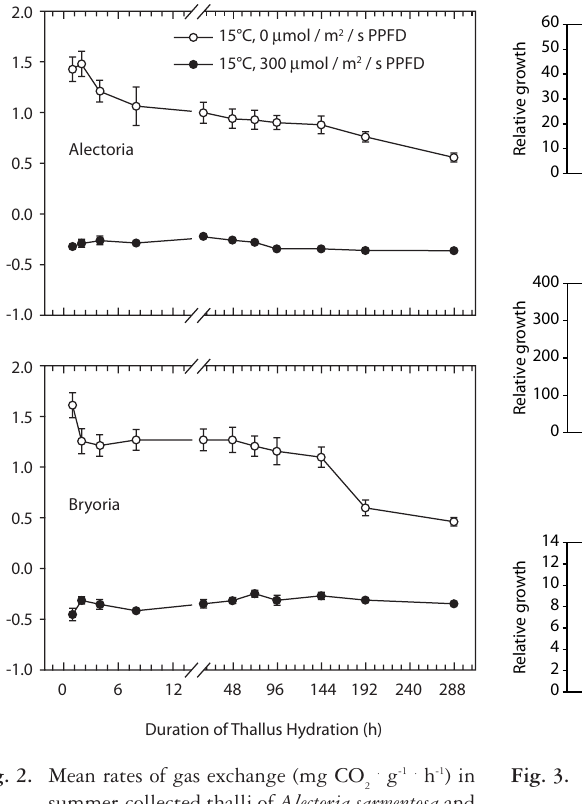
Fig. 3. Relative growth (per cent) and standard error Fig. 2. Mean rates of gas exchange (mg CO . g -1 . h -1 ) in 2 of Bryoria spp. and Alectoria sarmentosa thalli at summer-collected thalli of Alectoria sarmentosa and Bryoria spp. held at full thallus saturation for up three silvicultural systems study areas: Pinkerton CP376 (adapted from Stevenson et al ., 2001), to 288 h. Gas exchange measurements took place Lucille Mountain (S. Stevenson, unpubl. data; at 15ºC, and each of 0 and 300 µmol . g -1 . m -2 . s -1 methods in Stevenson, 2001), and Pinkerton photosynthetic photon flux density (PPFD) CP377 (adapted from Stevenson & Coxson, 2003). (reproduced from Coxson & Coyle, 2003). Within species, means sharing the same letter were not significantly different ( P >0.05; Bonferroni adjustment for multiple